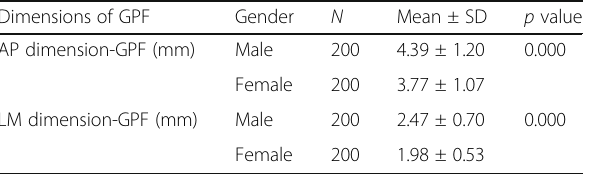
Table 6 The dimensions of the GPF based on gender Dimensions of GPF Gender